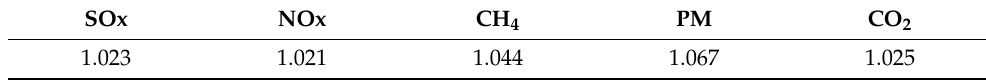
Table 10. Deterioration factors of various emissions from the marine engine. Unit: %/year. SOx NOx CH 4 PM CO 2 1.023 1.021 1.044 1.067